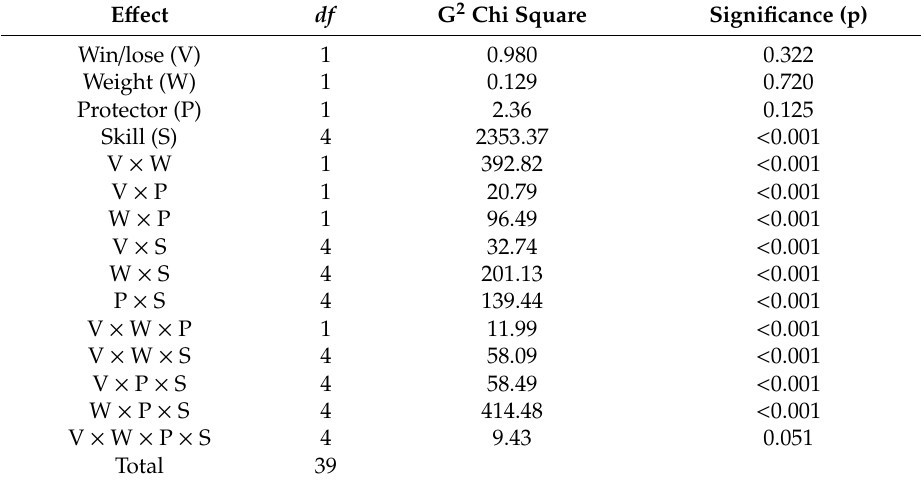
Table 3. Decomposition of G 2 partial associations for entire frequency tables.